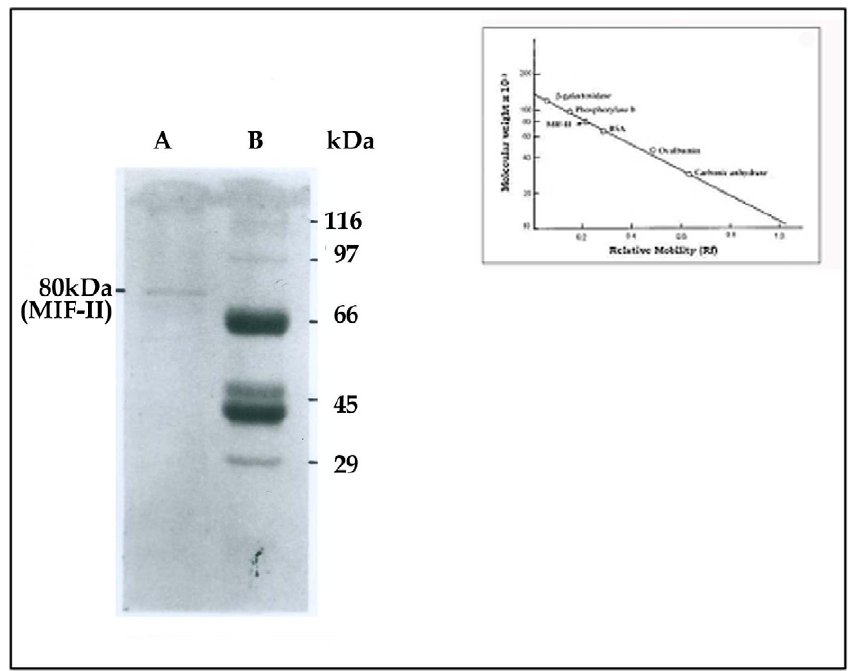
Figure 3. SDS-PAGE of MIF-II using 10% polyacrylamide gel. Markers used as standard were b -galactosidase (116 kDa), phosphorylase b (97 kDa), bovine serum albumin (66 kDa), ovalbumin (45 kDa) and carbonic anhydrase (29 kDa). Purified MIF-II (20 m g) was loaded.